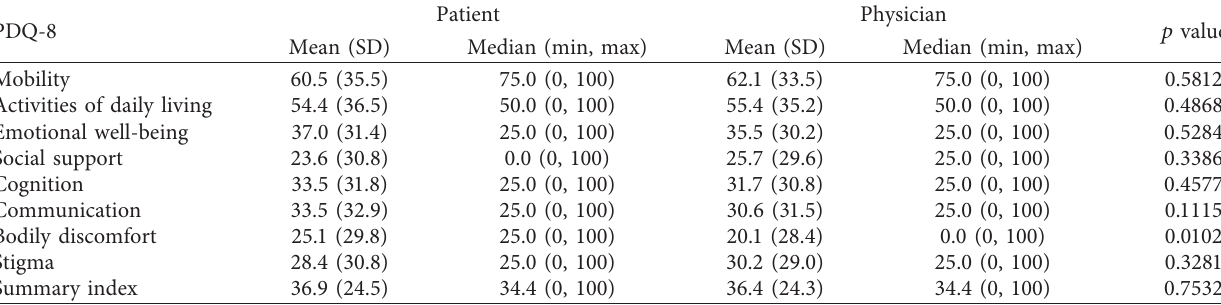
Table 6: Quality of life as assessed by patients and physicians